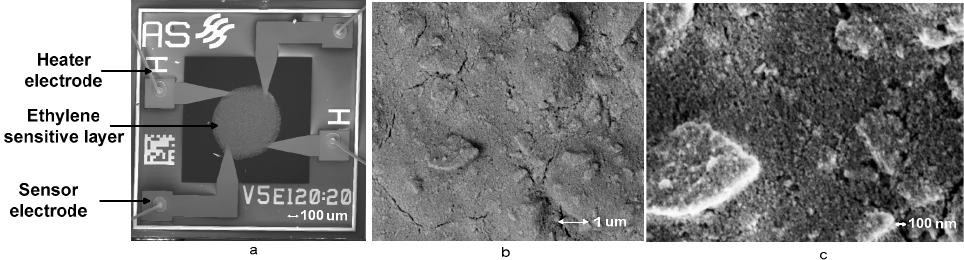
Figure 1. ( a ) SEM images of ASMLK gas sensor [14]; ( b ) a gas sensing layer; ( c ) a magnified image of the gas sensing layer.